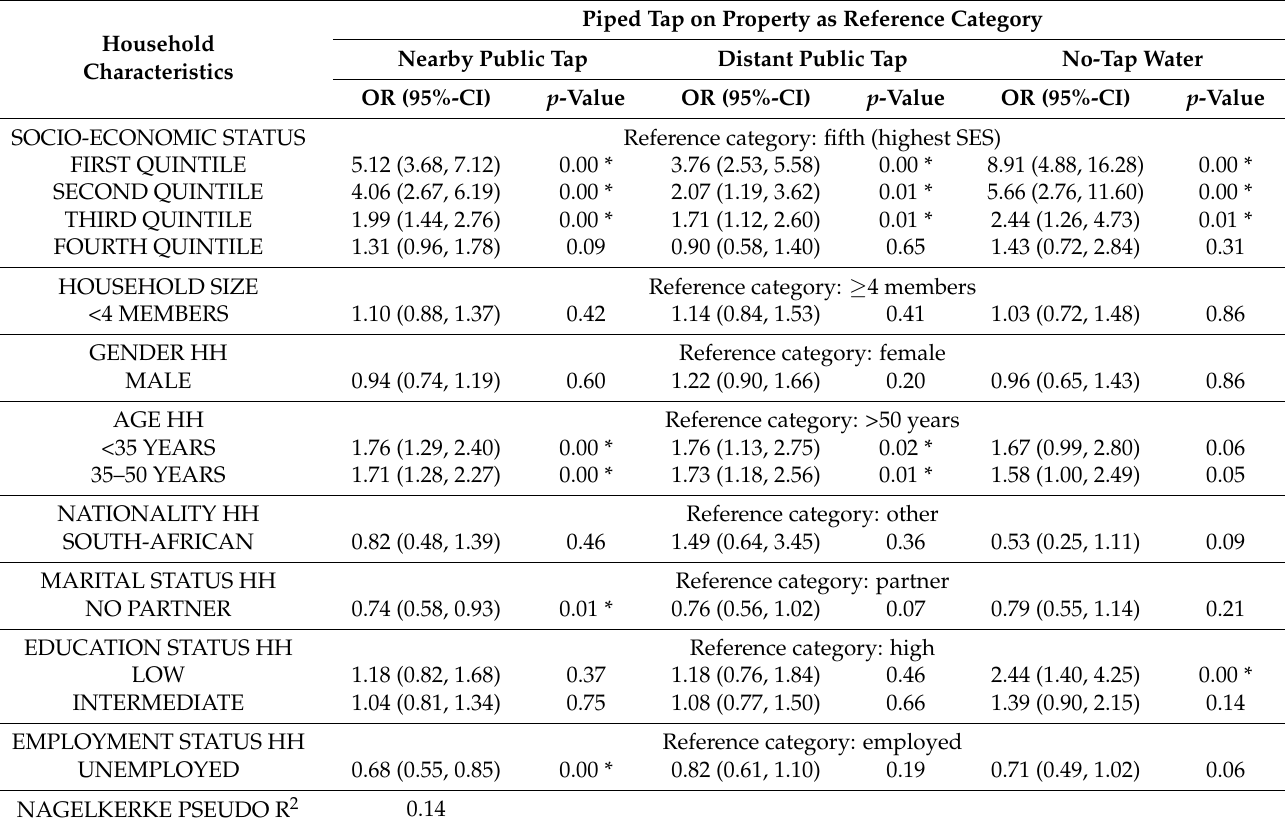
Table 2. Results of multivariate multinomial logistic regression analyses showing the associations between household characteristics and drinking water